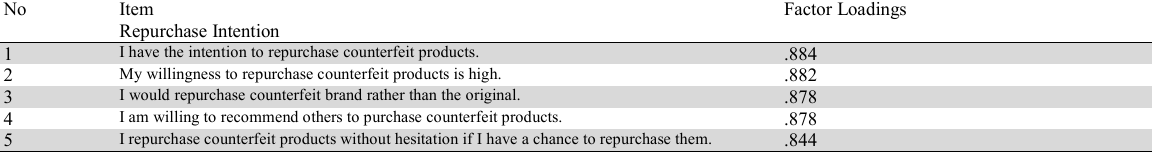
Factor analysis for the dependent variable (Repurchase Intension)